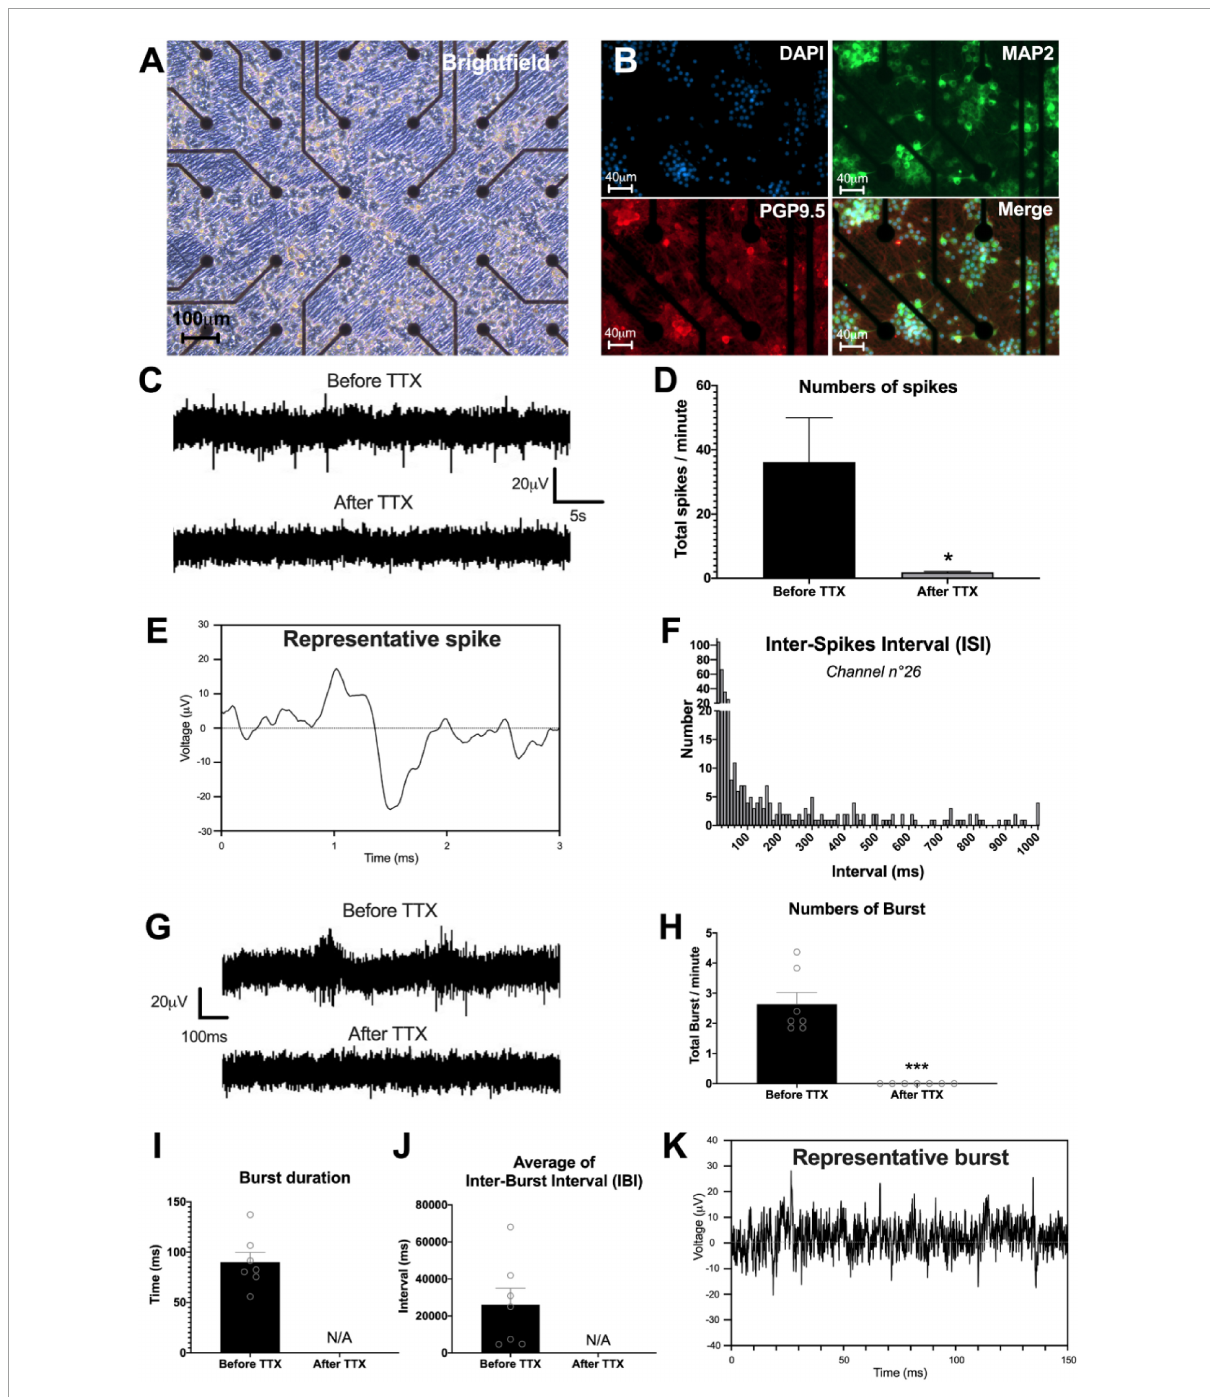
FIGURE7 Enteric neuronal network activity. (A–K) Analysis of neural network activity of highly pure cultures of enteric neurons by multi-electrode array (MEA) at D28. (A,B) Representative image of enteric neurons in MEA, (A) brightfield and (B) double immunostaining of enteric neurons at D28 with neuronal marker PGP 9.5 (red), MAP2 (green) and the cell nucleus marker DAPI (blue). (C) Representative voltage recording at one electrode, showing spontaneous firing and its inhibition by TTX treatment. (D) Numbers of spikes per minutes before and after TTX, average of 15 electrodes. (E) Detail of a representative enteric neuron spike measured by MEA. (F) Histogram representing an example of Inter-Spike Interval (ISI) measured on one electrode (n ◦ 26). (G) Single electrode recordings showing examples representative traces of two consecutive burst before and after TTX treatment. (H–J) Different parameters of burst measured by MEA before and after addition of TTX in the culture, i.e., (H) numbers, (I) duration, and (J) average of inter-burst interval. (K) Detail of a representative burst trace measured by MEA. Results were compared using t-test (* p < 0.05; *** p < 0.001). Data are presented as mean ± SEM of n = 3 chips from 3 independent rat